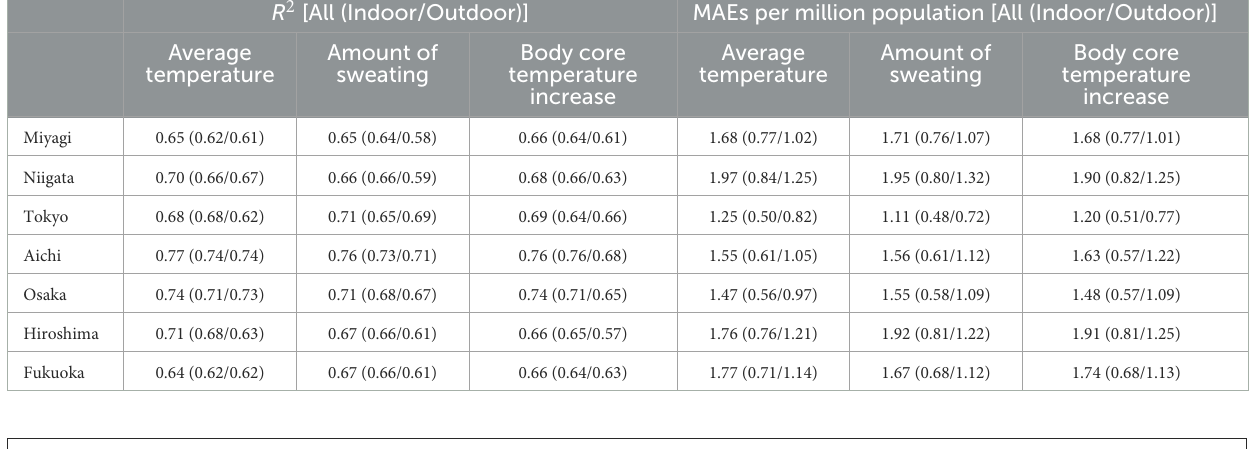
TABLE 4 Coefficient of determination R 2 and MAEs per million population in seven prefectures (averaged over the period from 2013 to 2019). R 2 [All (Indoor/Outdoor)] MAEs per million population [All (Indoor/Outdoor)]